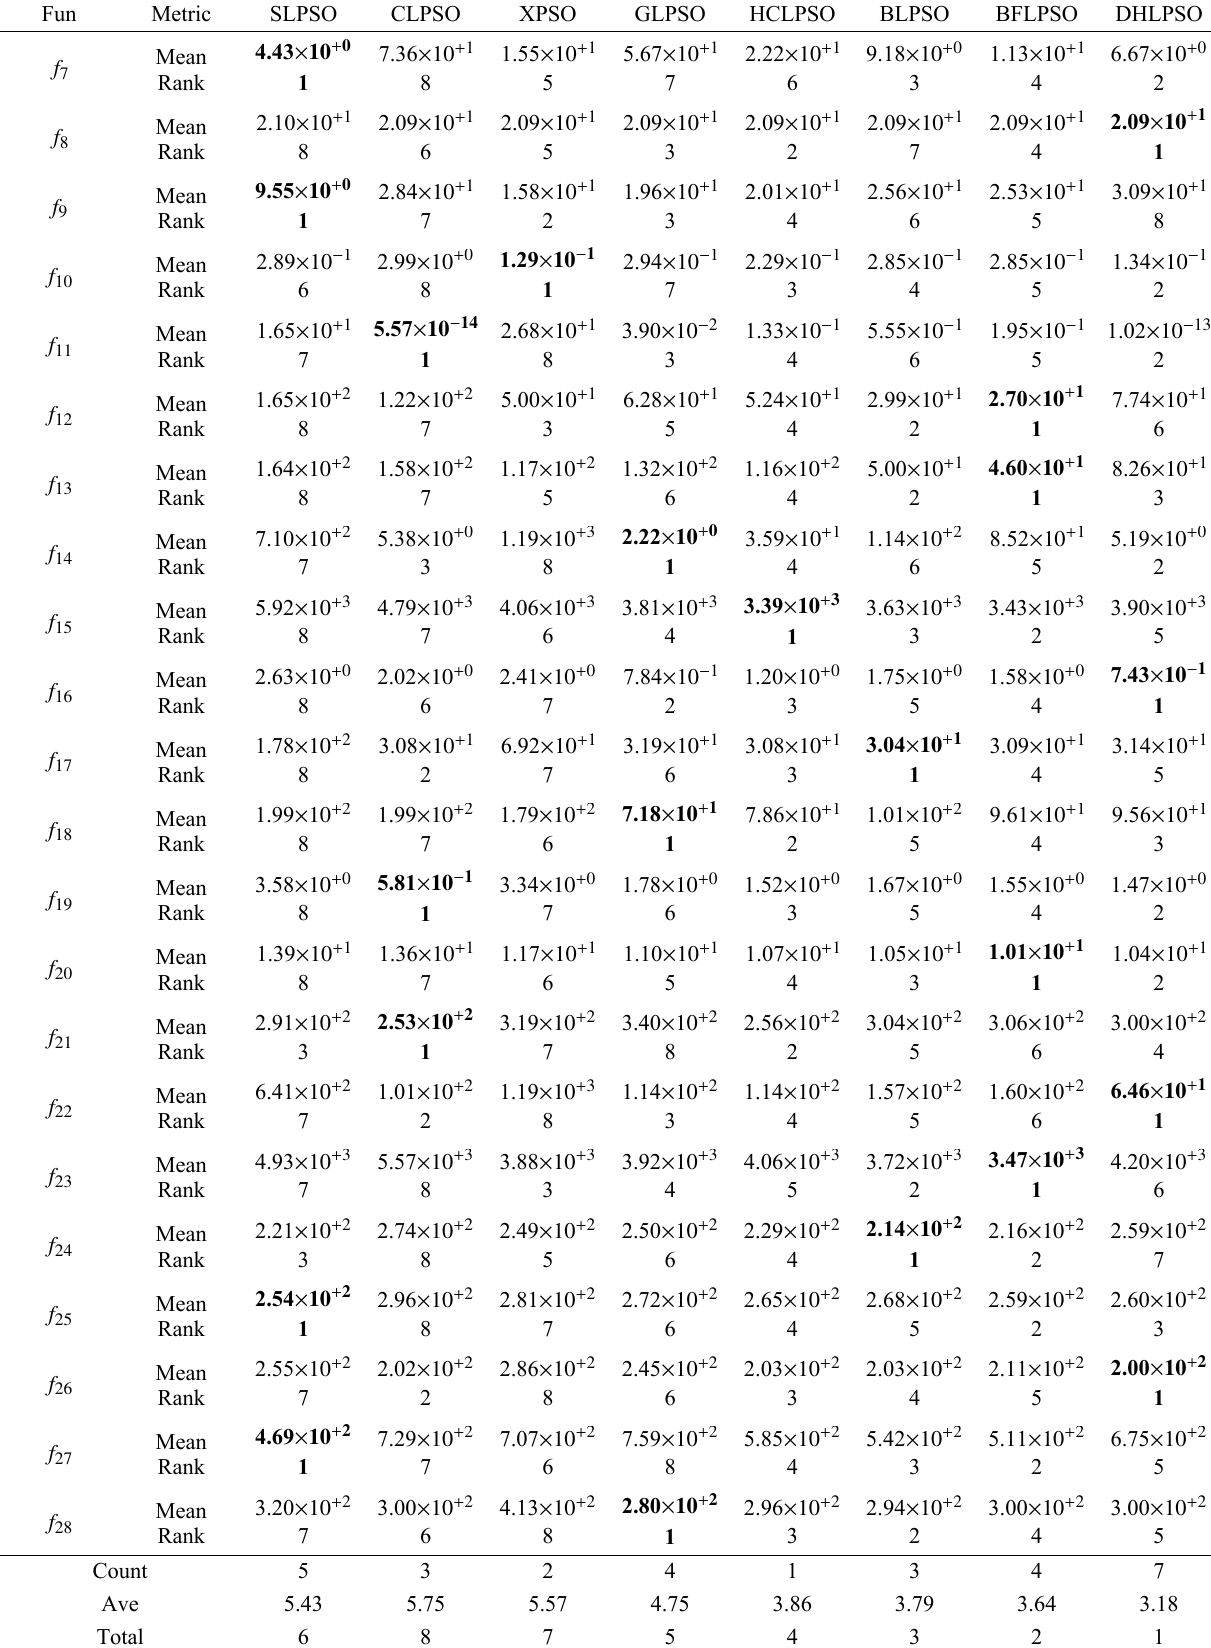
Table A3 Comparison results ( D =